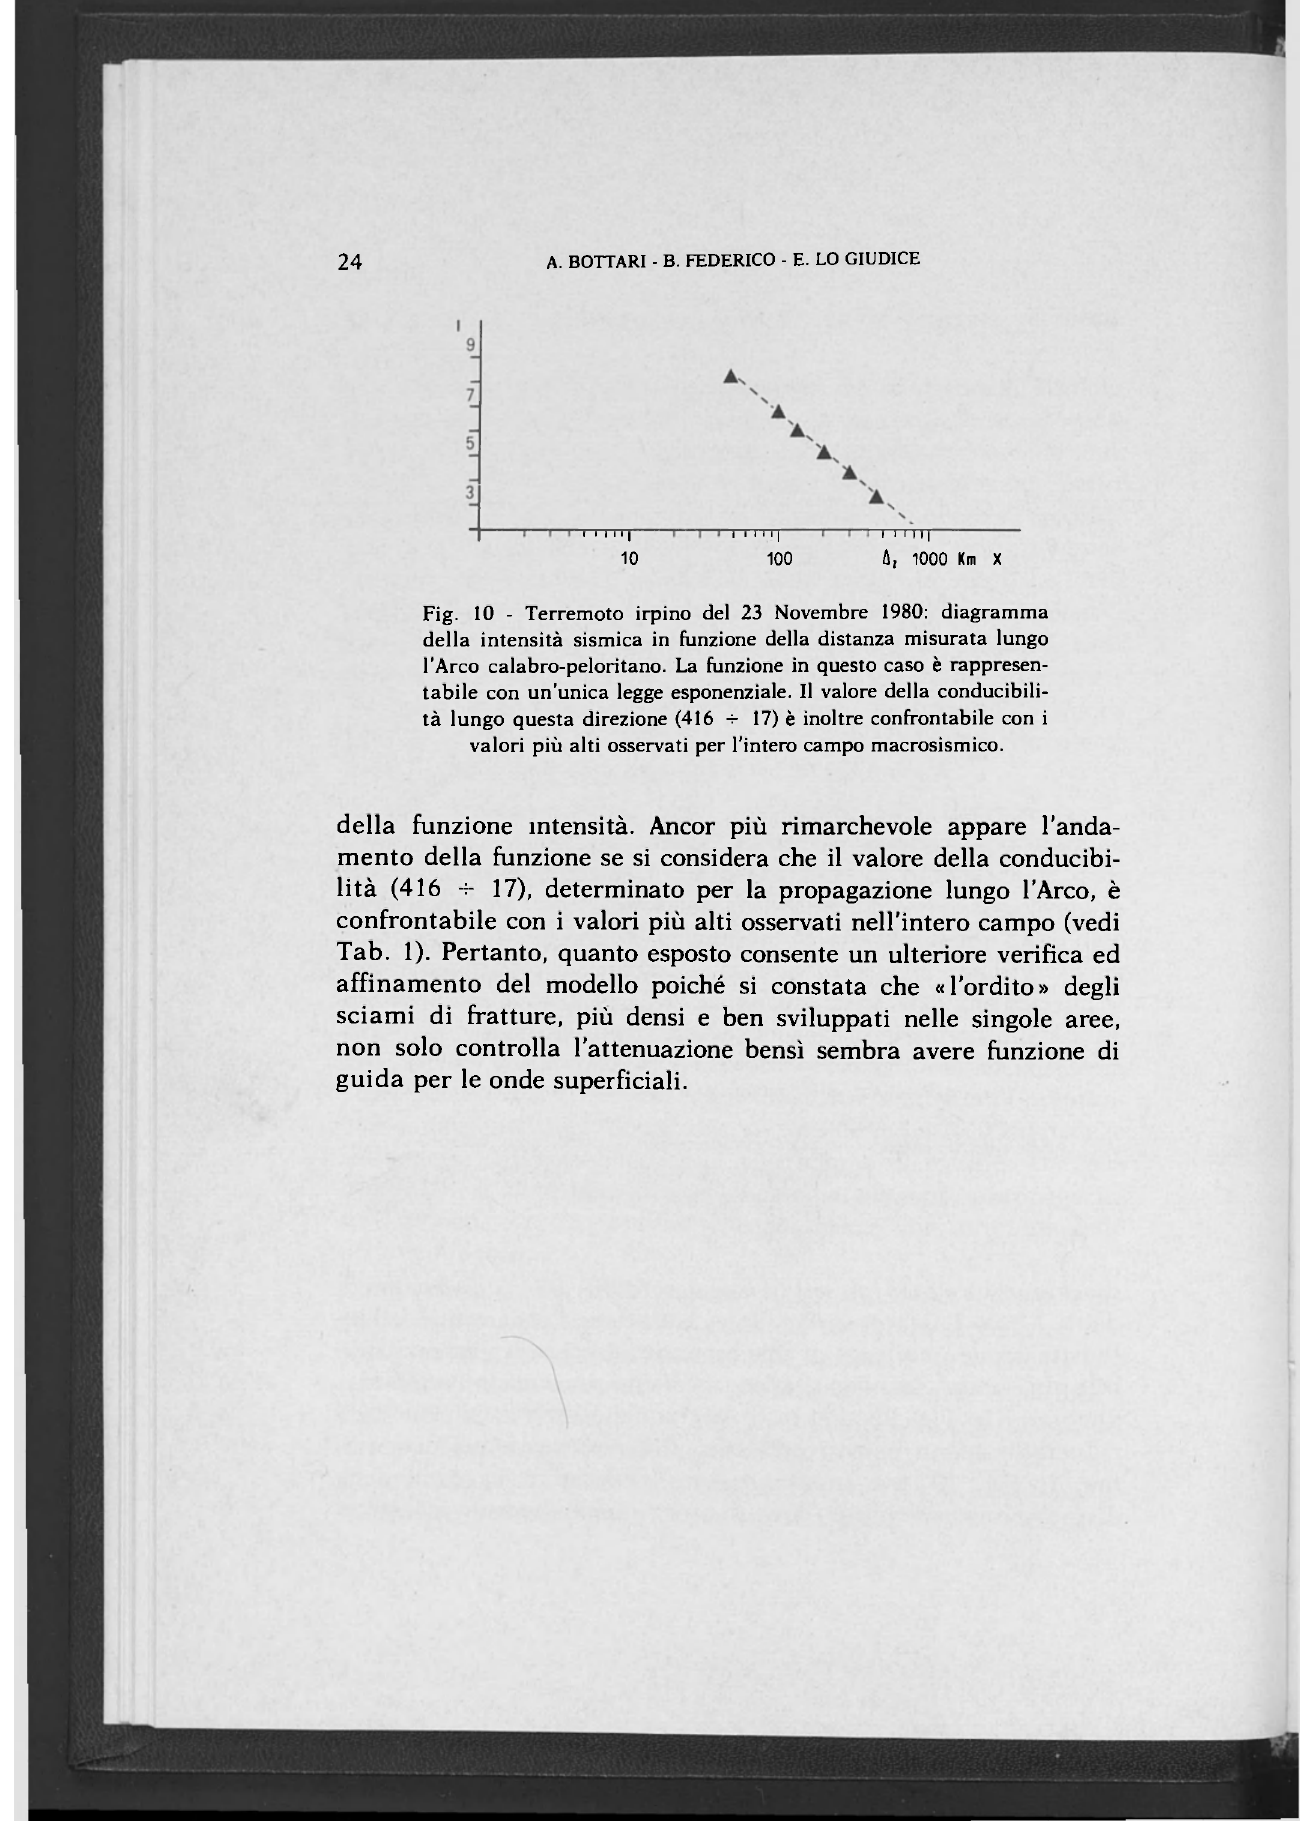
Fig. 10 - Terremoto irpino del 23 Novembre 1980: